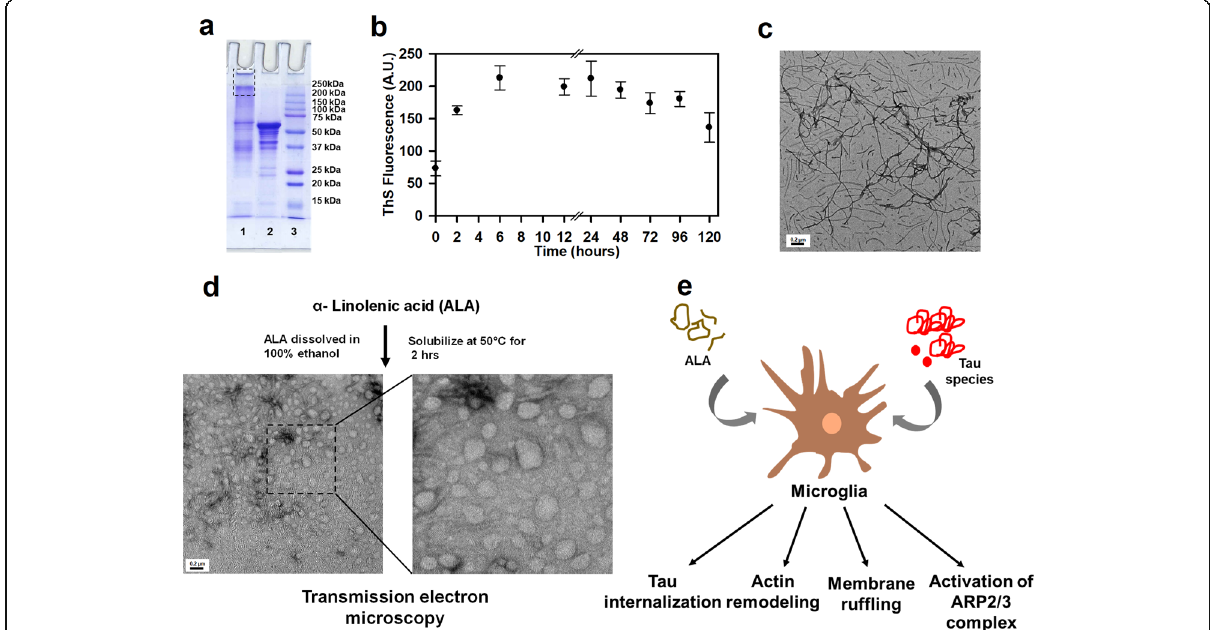
Fig. 1 Characterization of hTau40 aggregates and experimental outline. a Human Tau40 aggregates were prepared for cellular studies. Tau aggregation was carried out in presence of heparin for 120 h. Higher-order aggregates have been characterized by SDS-PAGE analysis. The protein band for higher-order aggregates were visible above 250 kDa (lane 1), the protein band corresponding to monomer is indicated (lane 2). b Tau aggregates were studied by ThS fluorescence kinetics for 120 h. c Tau aggregates were visualized via transmission electron microscopy (TEM) to understand Tau fibrils formation, scale bar is 0.2 μ m. d ALA was prepared as a starting material in the presence of 100% ethanol and solubilized at 50 °C for 2 h. The transmission electron microscope image indicates the morphology of ALA, scale bar is 200 nm. e Schematic representation of experimental proceeding depicts the role of ALA in phagocytosis of extracellular Tau and necessary actin remodeling for the